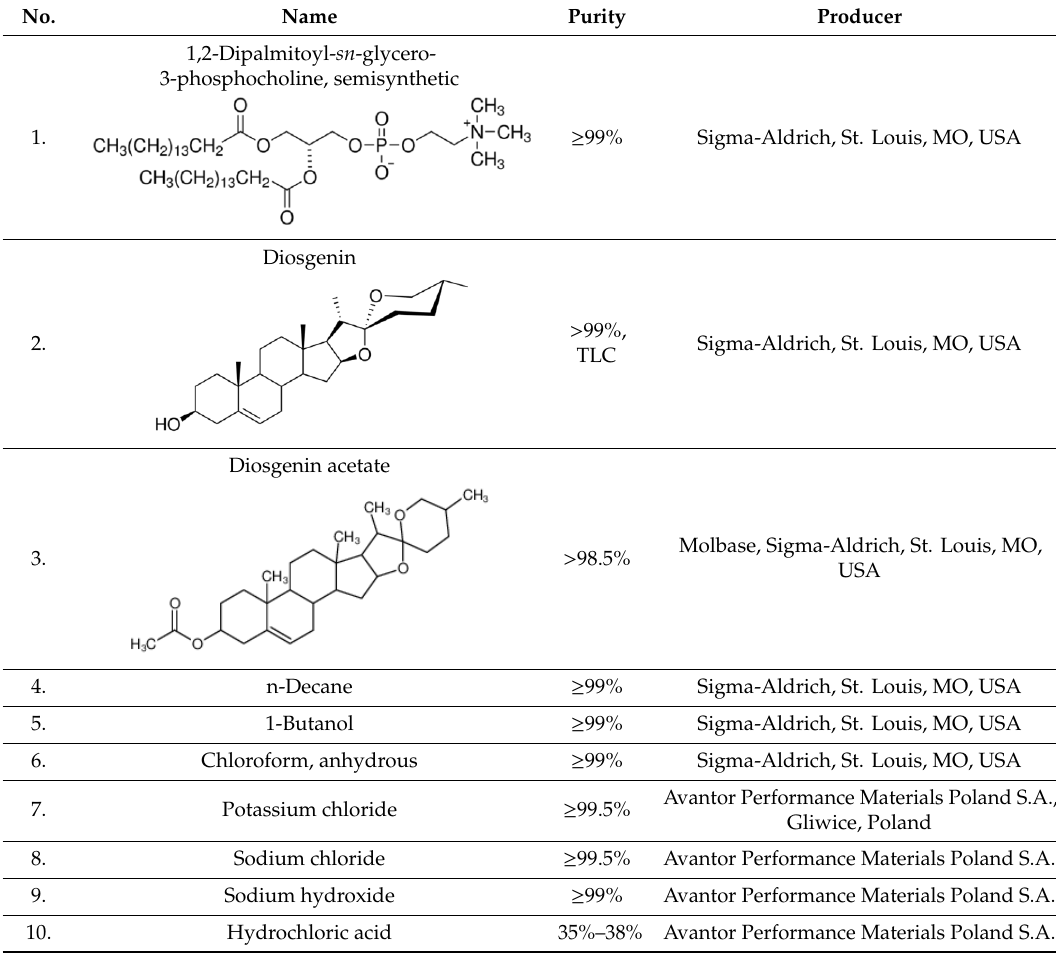
Table 1. Reagents used in experiments.